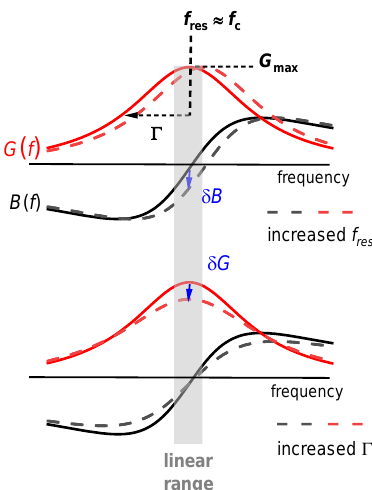
Figure 7. Impedance analysis requires a determination of the entire admittance trace (full and dashed lines), which takes time. Fast measurements can build on the conductance, G el , and the susceptance, B el , at one single frequency close to the center of the resonance, f c . Shifts in G el and B el are converted to shifts in f res and Γ (blue arrows). As the top panel shows, a shift in resonance frequency changes B el , but leaves G el unchanged. Conversely, an increase in bandwidth lowers G el , but leaves B el unchanged (bottom).